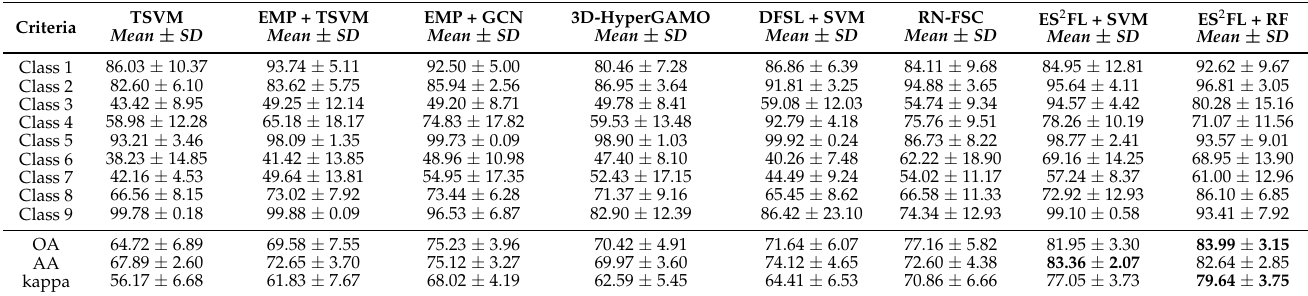
Table 4. The classification results of different methods on the UP data set in the case of small samples. SD denotes the standard deviation of 10 experimental